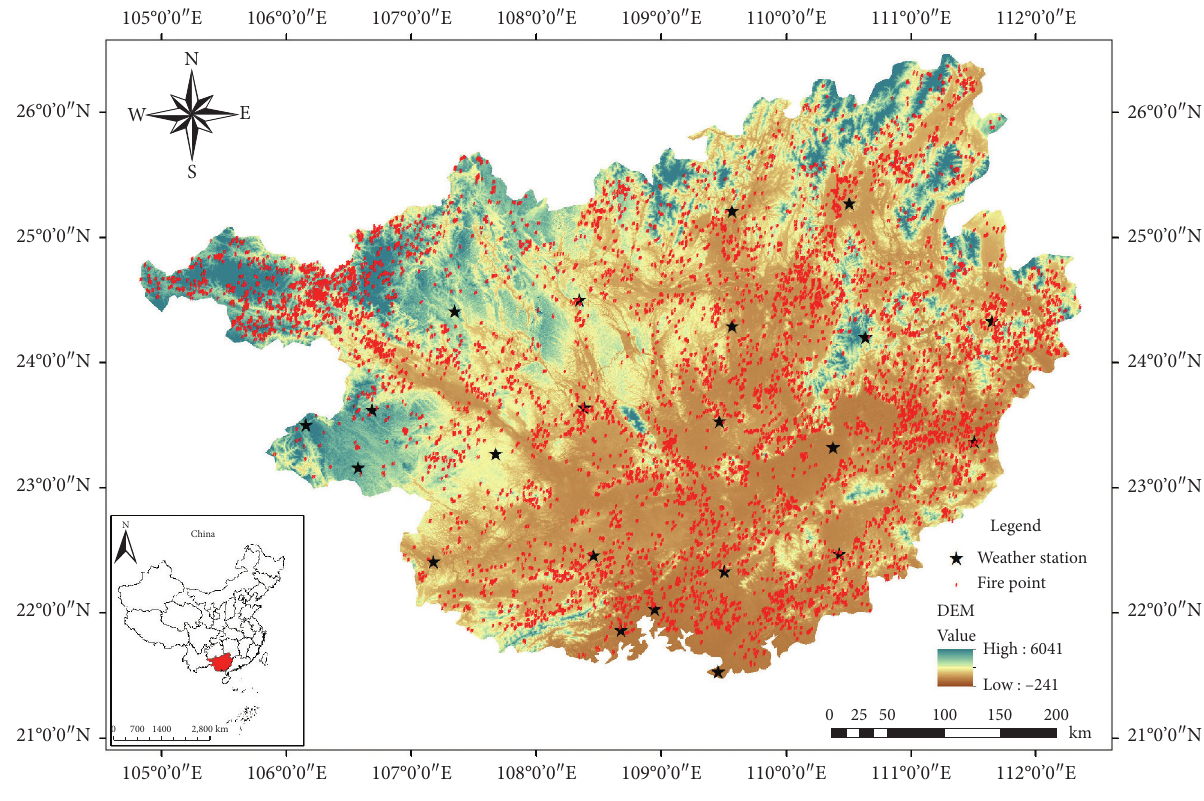
Figure 1: Survey of the study area.